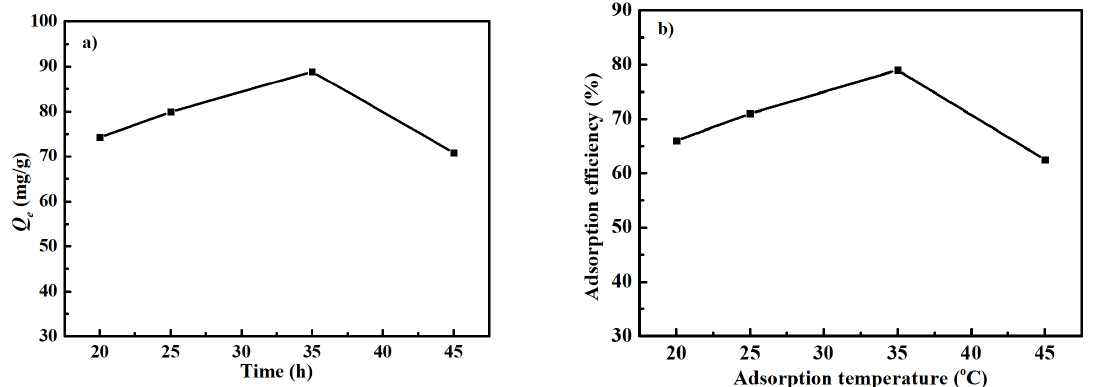
Figure 7. The Cd 2+ adsorption capacity Q e ( a ) and adsorption efficiency ( b ) of the carbonized ZIF−8@PAN nanofiber membrane at various adsorption temperatures and pH = 6.5.